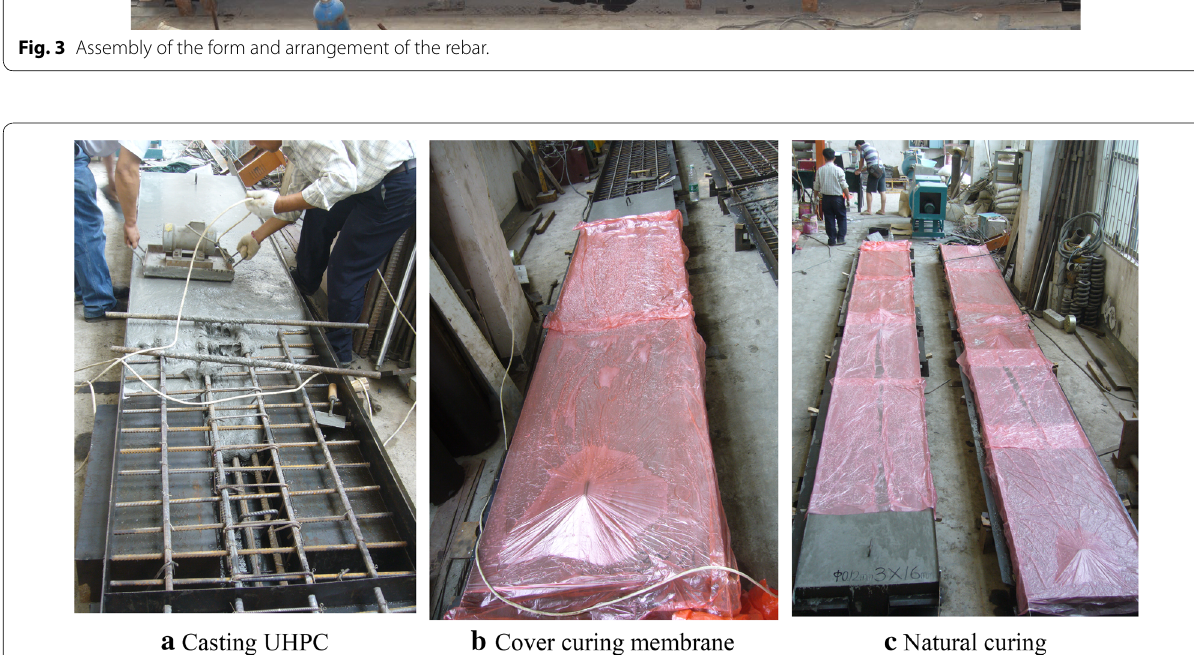
Fig. 4 Process of casting UHPC and natural